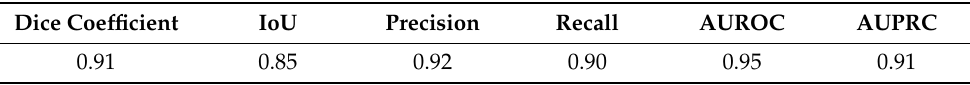
Table 5. Fourfold cross-validation results of the Infection segmentation model calculated as the mean of